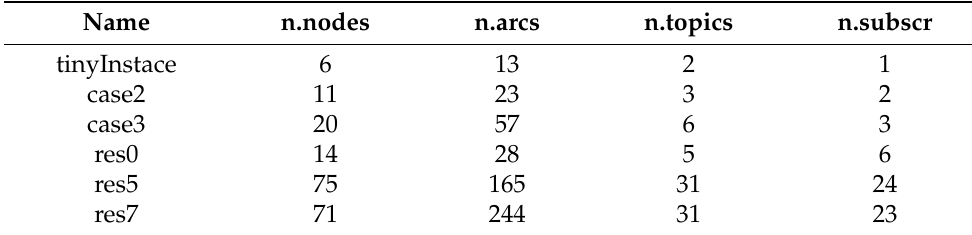
Table 1. Initial